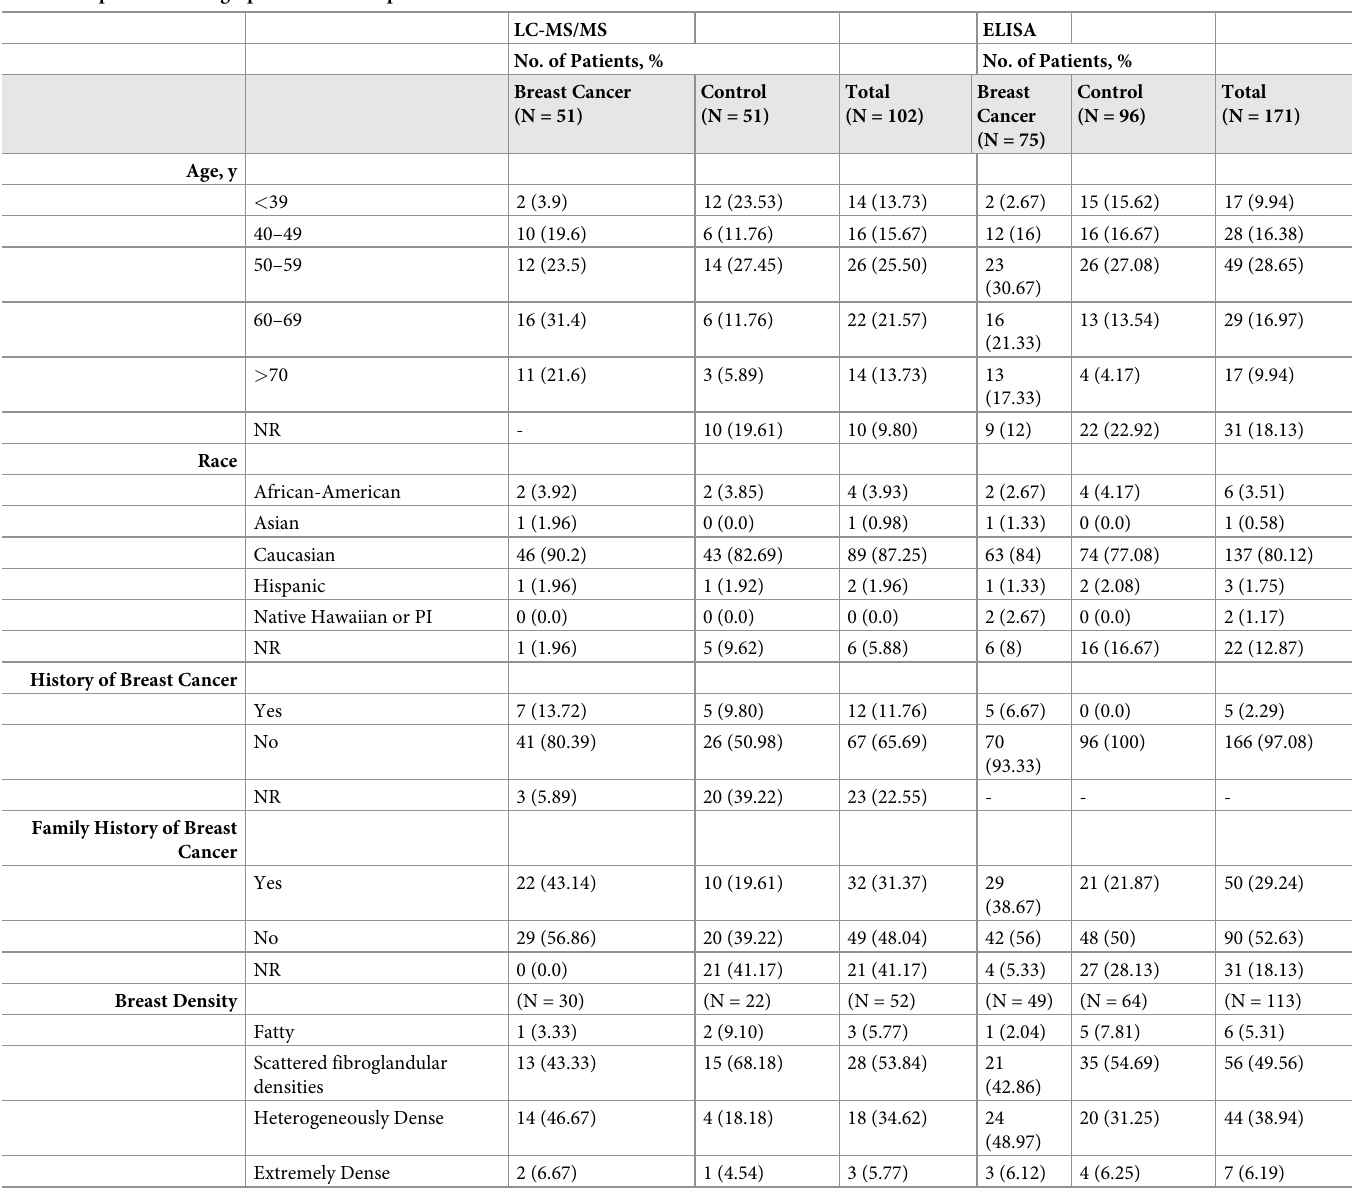
Table 2. Population demographics of tear samples used for LC-MS/MS and